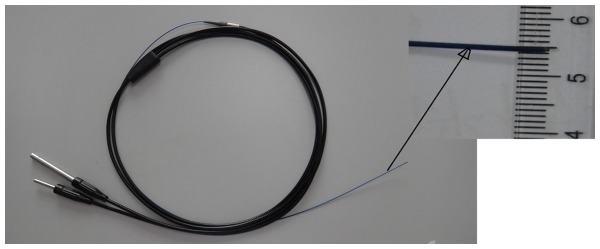
of the entire micro-imaging fiber, showing the body of the fiberscope, objective lens, and connection to camera.